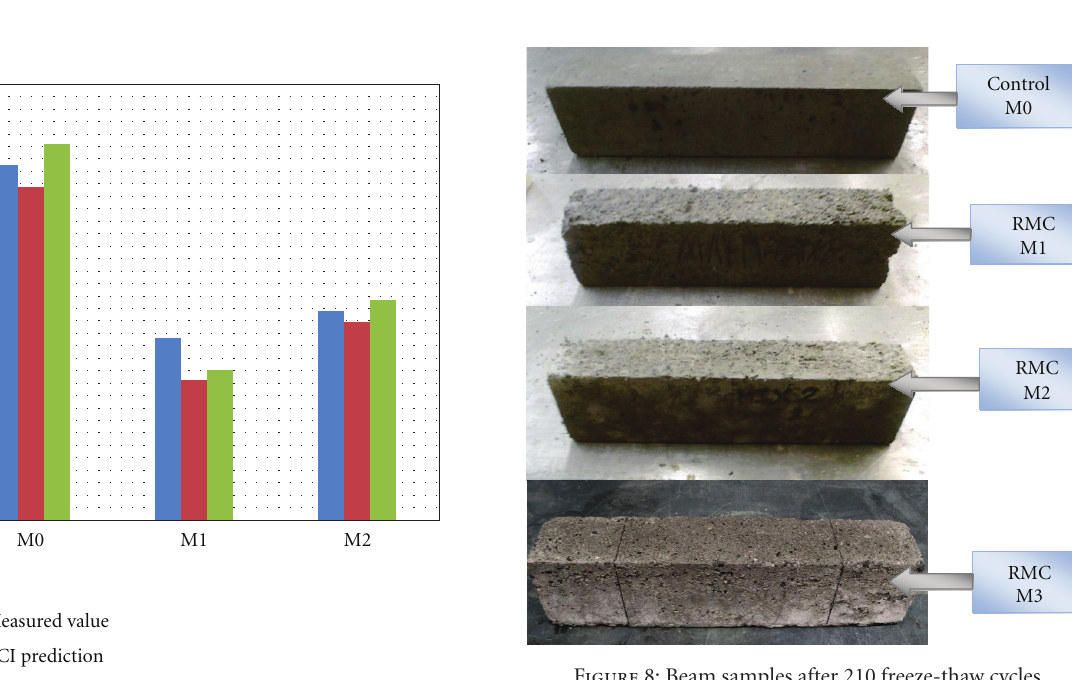
Figure 8: Beam samples after 210 freeze-thaw cycles. Table 2: Torrent permeability